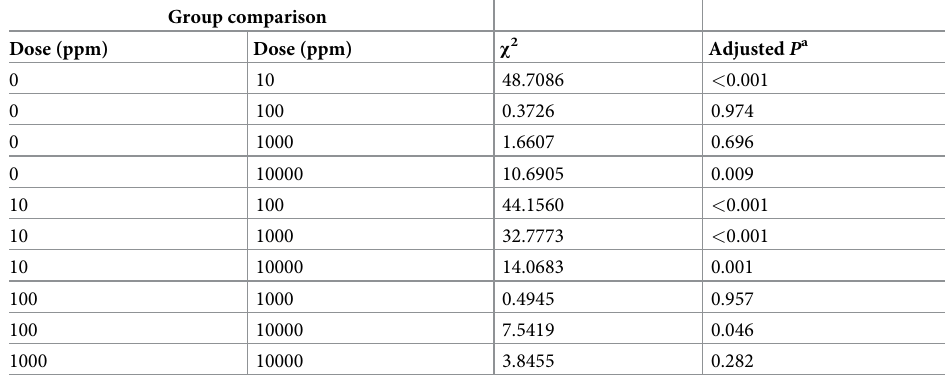
a P -values from pair-wise comparisons were adjusted for multiplicity using the SIMULATE option of the LIFETEST procedure of SAS [56].